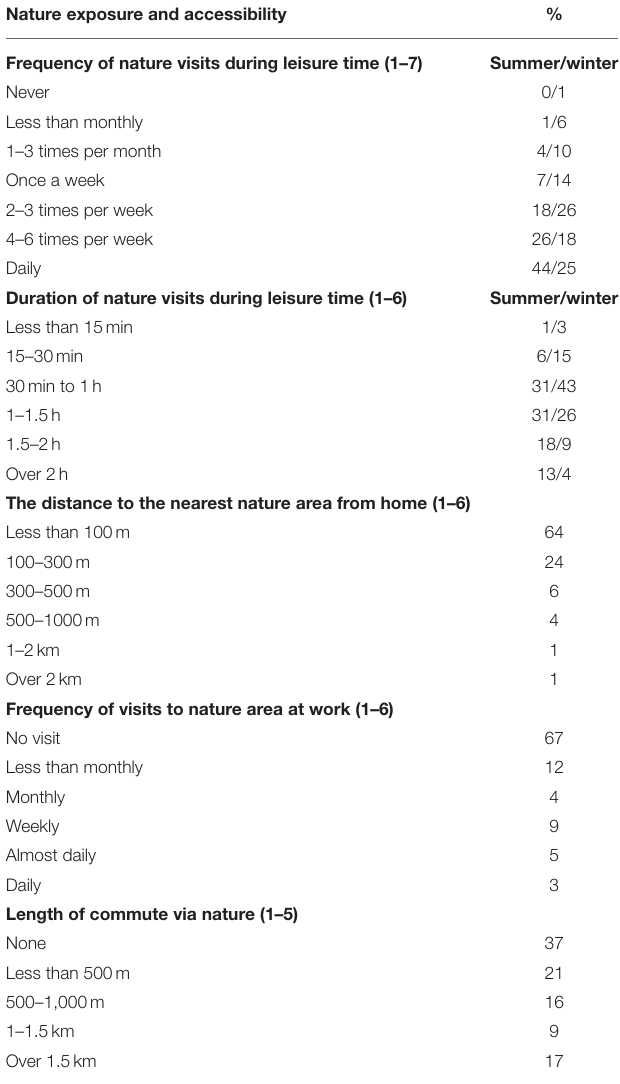
TABLE 1 | Percentages for variables describing participants’ nature exposure and accessibility to nature areas. Nature exposure and